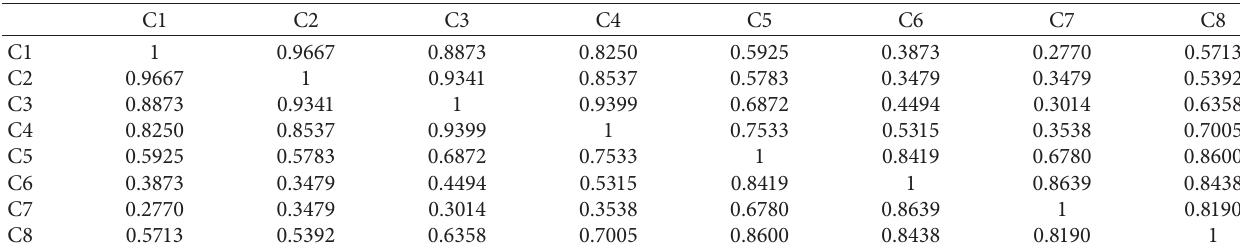
Figure 4: Parking arrival volume of different parking duration categories. (a) Parking arrival volumes of different parking duration categories on one week for whole samples. (b) Parking arrival volumes of categories 1, 2, and 3 on 24 hours. (c) Parking arrival volume of categories 4 and 5 on 24 hours. (d) Parking arrival volumes of categories 6, 7, and 8 on 24 hours. Table 1: Cosine similarity between each parking duration